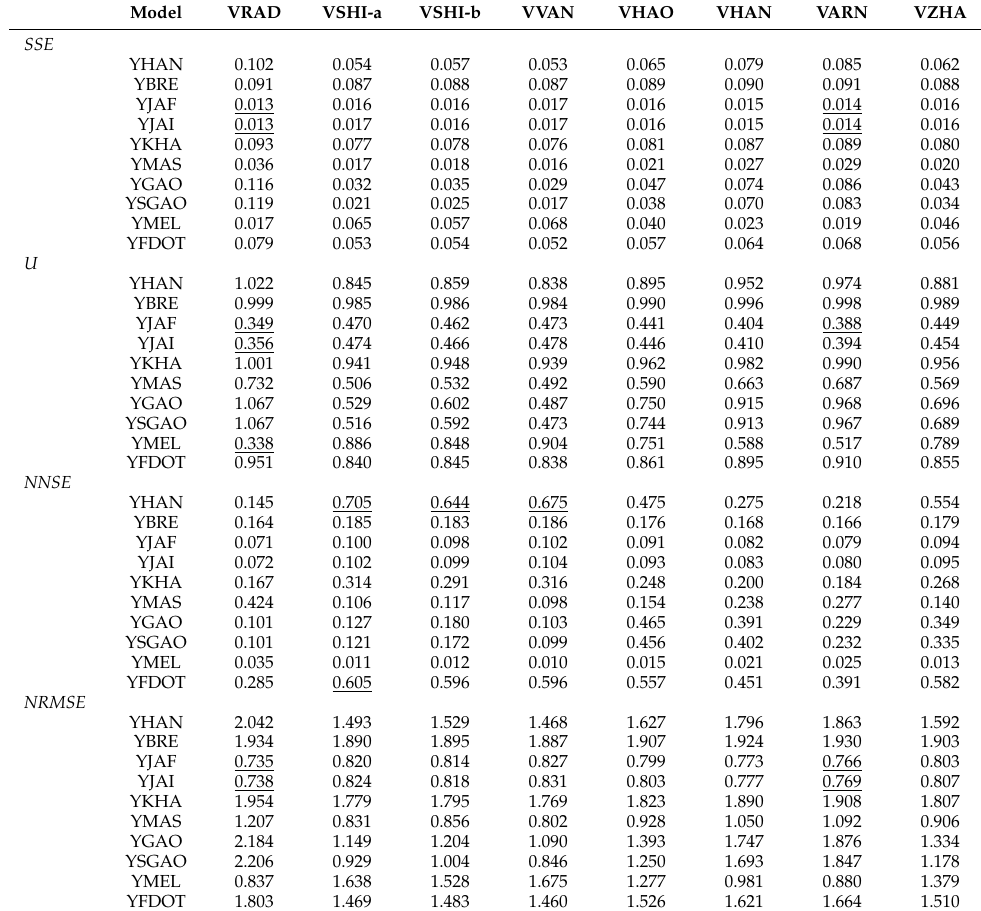
Table 4. Summary of statistical parameters used to compare the selected equations *.